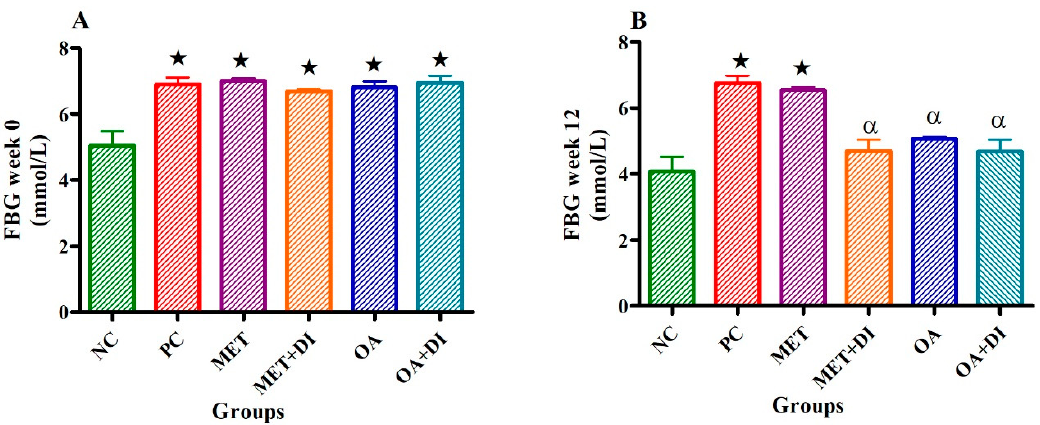
Figure 1. Effects of OA and Met ( n = 6, per group) on fasting blood glucose of rats that continued with HFHC diet and those that changed diet or had diet intervention at week 0 ( A ) and week 12 ( B ) respectively. Values are presented as standard error of mean ± SEM. = p < 0.05 denotes comparison with NC; α = p < 0.05 denotes comparison with PC.